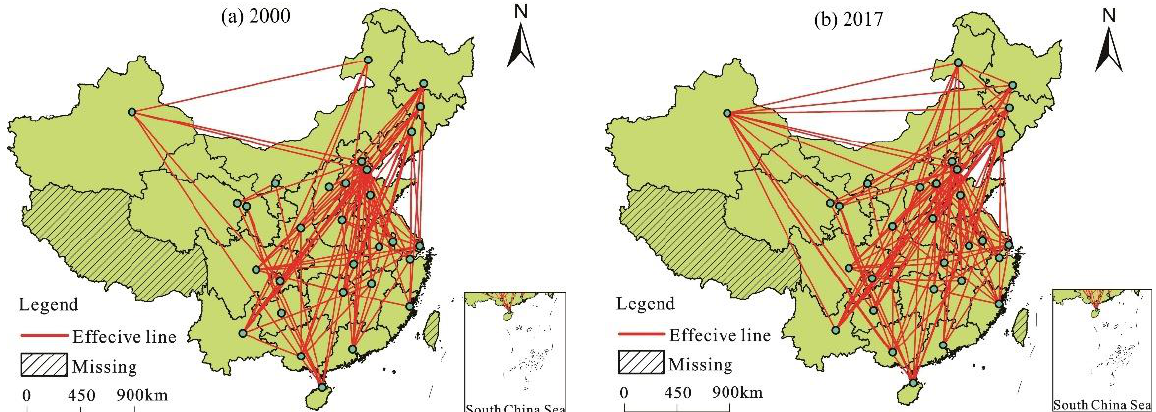
Figure 2. Spatial network structure of tourism eco-efficiency in year 2000 ( a ), and 2017 ( b ), China.